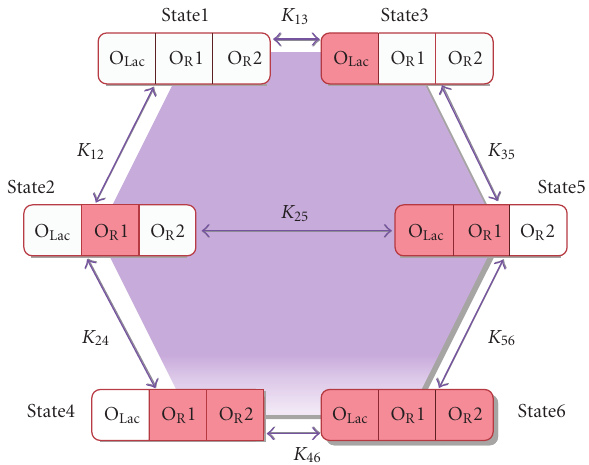
Figure 8: The six possible binding states in the repressor-activator model in Guido et al. [8]. The rectangular boxes represent the three available operator sites of engineered O R O lac promoter. Unbound sites are depicted with unfilled (white) boxes; filled (pink) boxes depict sites bound by the appropriate protein (lacI to O lac , cI to O R 1 and O R 2). Of the eight (2 3 ) possible states, two are not feasible. This is because cI binds sequentially to the O R 1 and O R 2 sites so that O R 2 cannot bind unless O R 1 is also bound. The model parameters K 12 through K 56 are the rate constants for the transitions between each possible binding state (adapted from Guido et al.